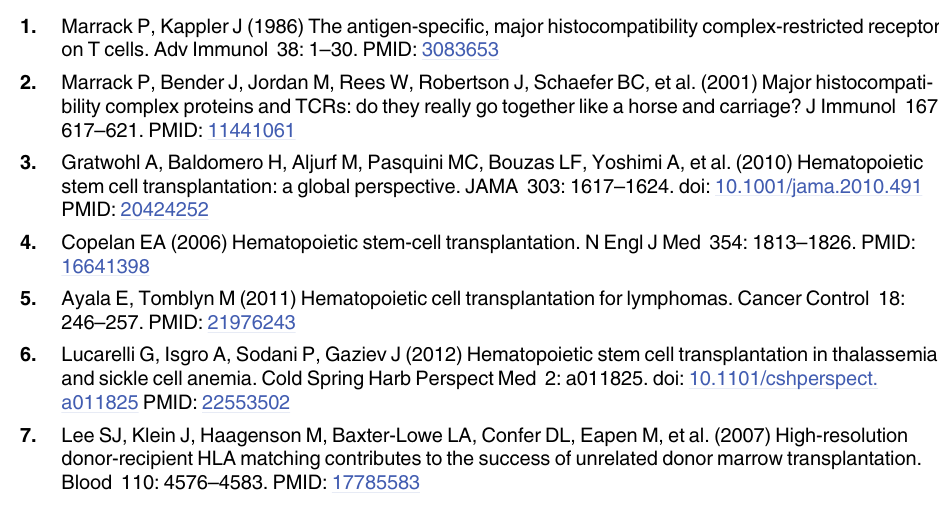
S8 Table. Common (freq. > 1 ‰ ) HLA four-locus haplotypes among the 169,995 CMDP reg- istry donors. S9 Table. Common (freq. > 1 ‰ ) HLA five-locus haplotypes among the 169,995 CMDP reg- istry donors. S10 Table. The numbers of donors from each of the geographic regions of China. (DOCX) S11 Table. Frequencies of several distinctive haplotypes in each of the geographic regions. (DOCX) S12 Table. HLA matches within each region of